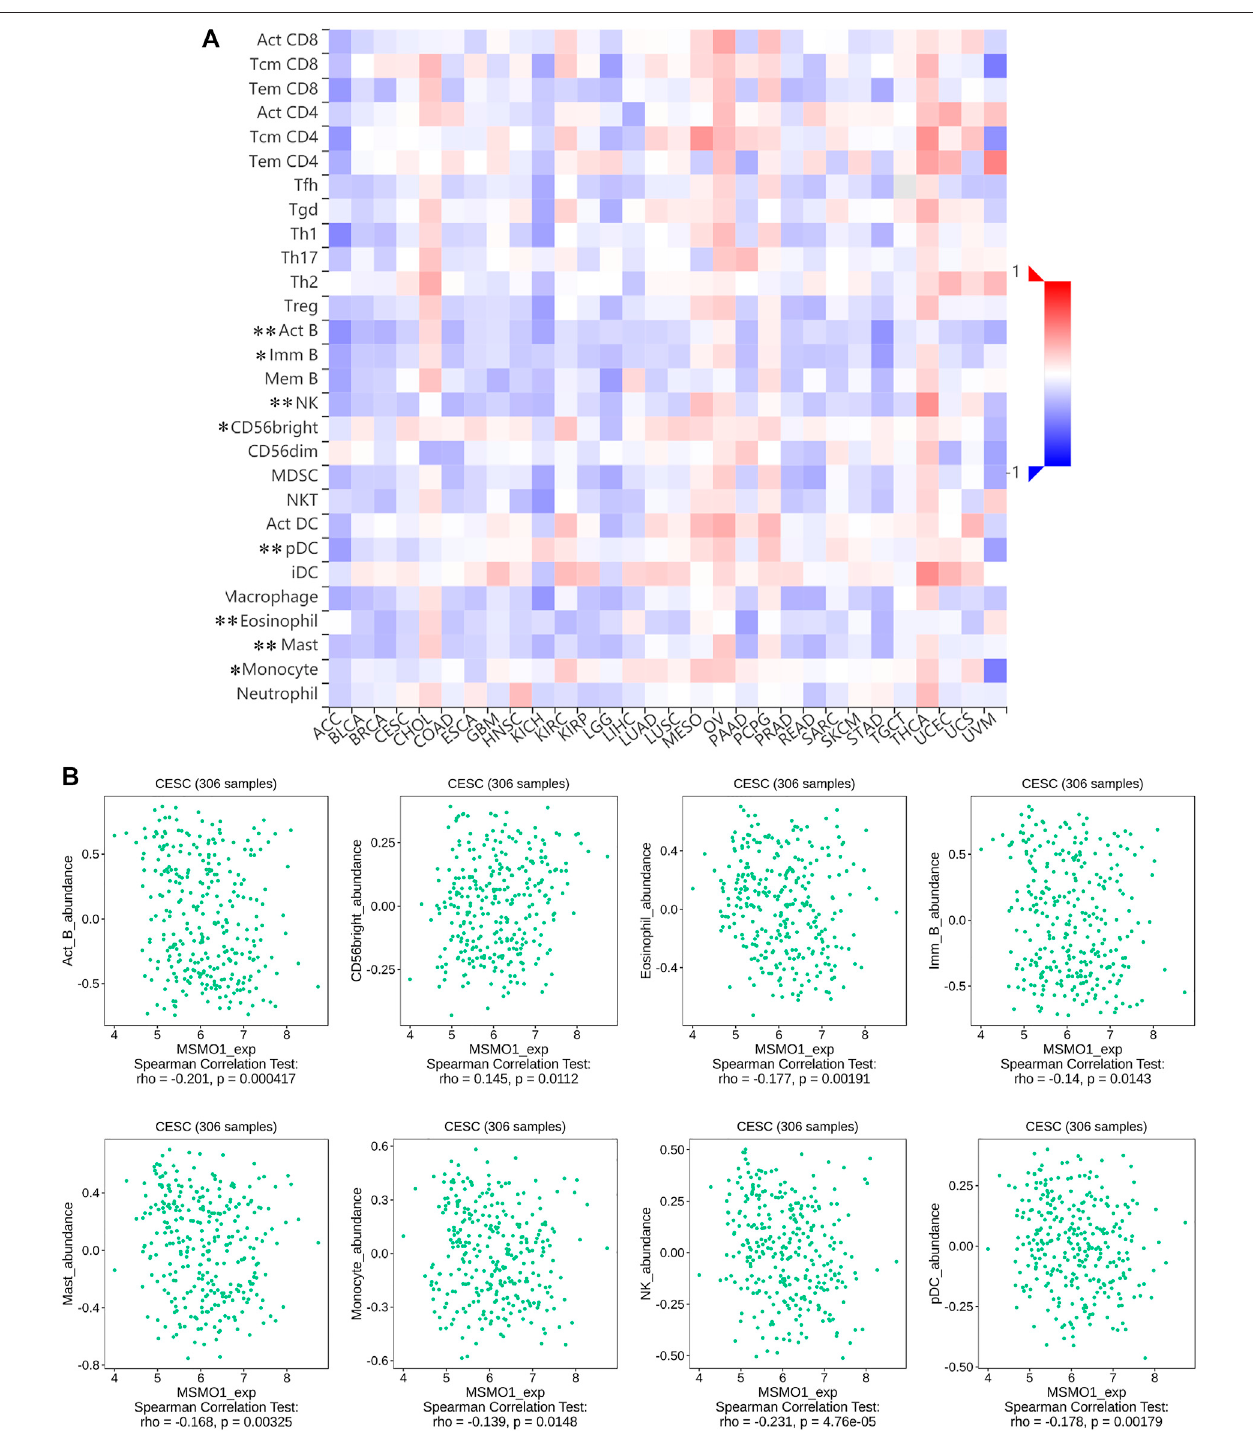
FIGURE 12 | Correlation between MSMO1 expression levels and immune cell subsets. (A) The black asterisks in the correlation heatmap indicate immune cell types signi fi cantlyassociated withMSMO1 expression levels inCESC cohorts, respectively.(* p < 0.05; ** p < 0.01). (B) The dot plots displayed thecorrelationsbetween MSMO1 expression levels and immune cell subsets in CESC.